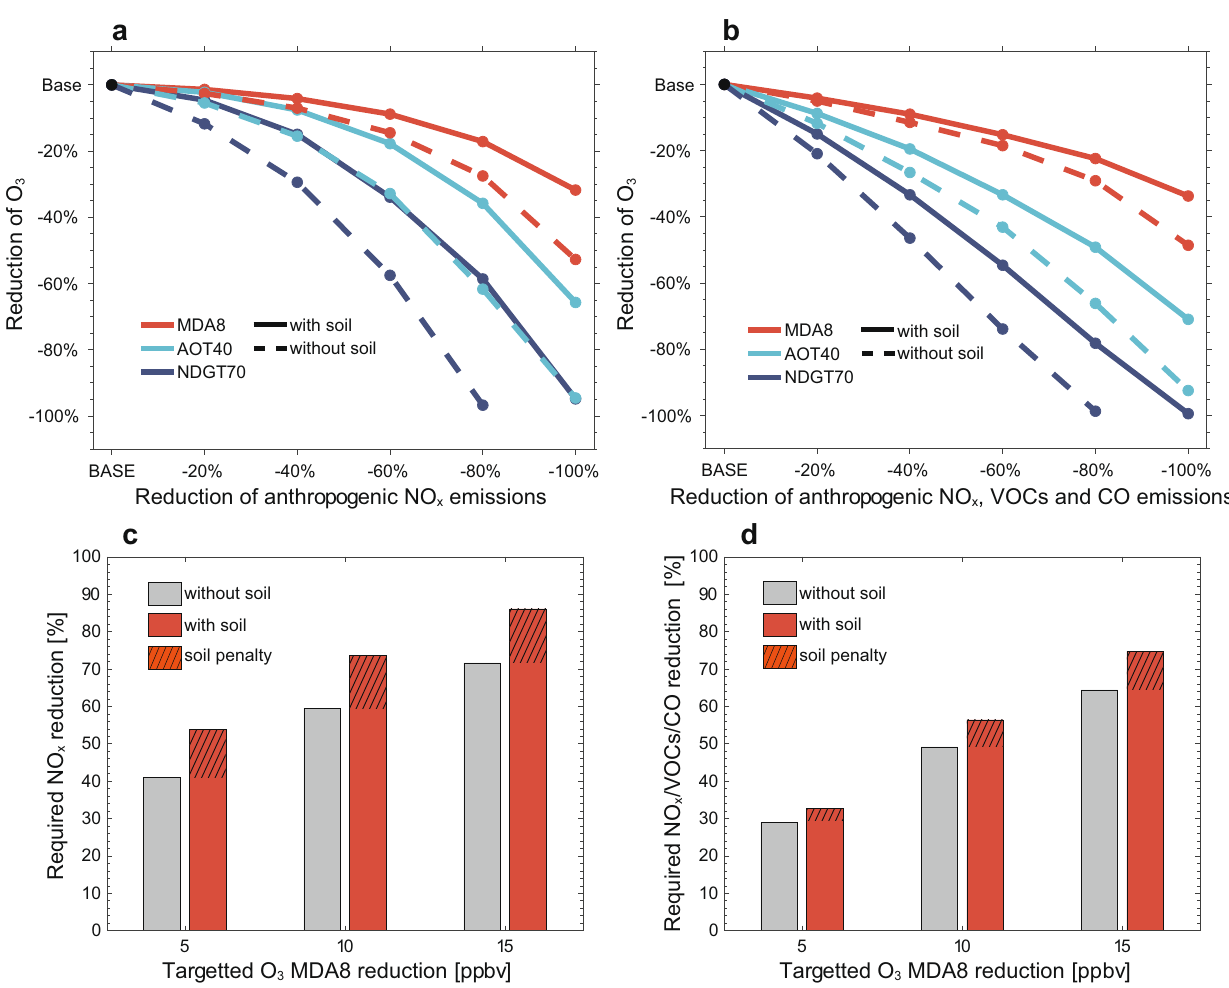
Fig. 4 The “ soil NO x emission penalty ” on anthropogenic ozone pollution regulation averaged in the 55 NCP cities. Panels a and b show the responses of ozone metrics (MDA8, AOT40, and NDGT70, Methods) to the reductions of anthropogenic NO x emissions, and the joint reductions of anthropogenic NO x , VOCs, and CO emissions, respectively. Panels c and d show the required reduction of anthropogenic NO x emissions or joint reduction of anthropogenic NO x , VOCs, and CO emissions for different ozone control targets in the NCP cities, estimated from panels a and b by a logarithmic fi tting (Supplementary Table 5), both in the presence (gray) and absence (red) of soil NO x emissions. The difference between the red and gray bars thus illustrates the soil NO x emission penalty, i.e., extra anthropogenic emission reduction imposed by the presence of high soil NO x